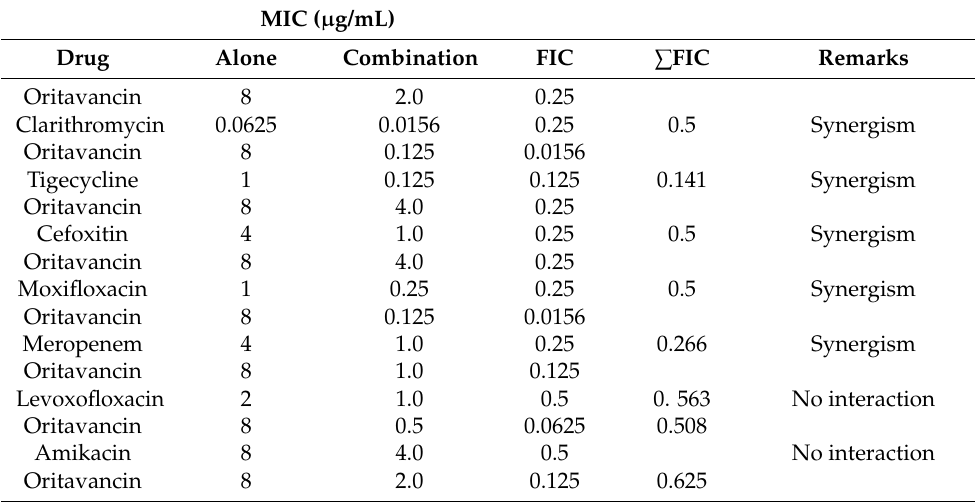
Figure 2. In vitro and intracellular bactericidal activity of oritavancin against M. abscessus and M. bovis BCG. Bactericidal activity of oritavancin against M. abscessus ( a ) and M. bovis BCG ( b ) was determined with different concentrations of oritavancin. And effect of oritavancin on M. abscessus ( c ) and M. bovis BCG ( d ) of viability in THP-1 cells was determined on 72 h after treatment with 2 × MIC and 8 × MIC oritavancin. Data are expressed as the mean ± standard deviation (SD) of triplicates for each concentration. The error bar is smaller than the symbol size and not showed. *** p < 0.001. ORI: oritavancin, AMK: amikacin. Table 2. Synergy of oritavancin and approved